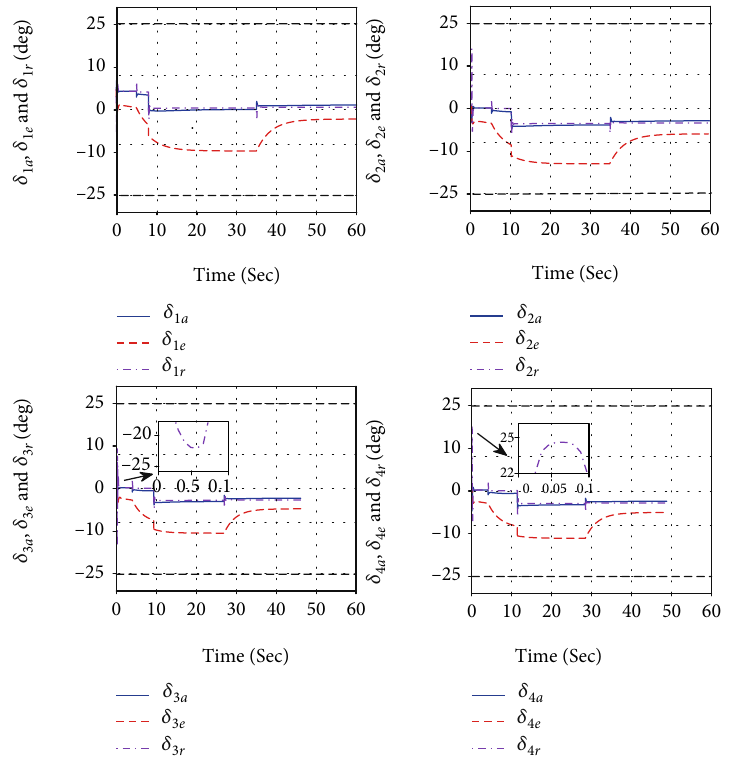
Figure 9: Control input signals δ